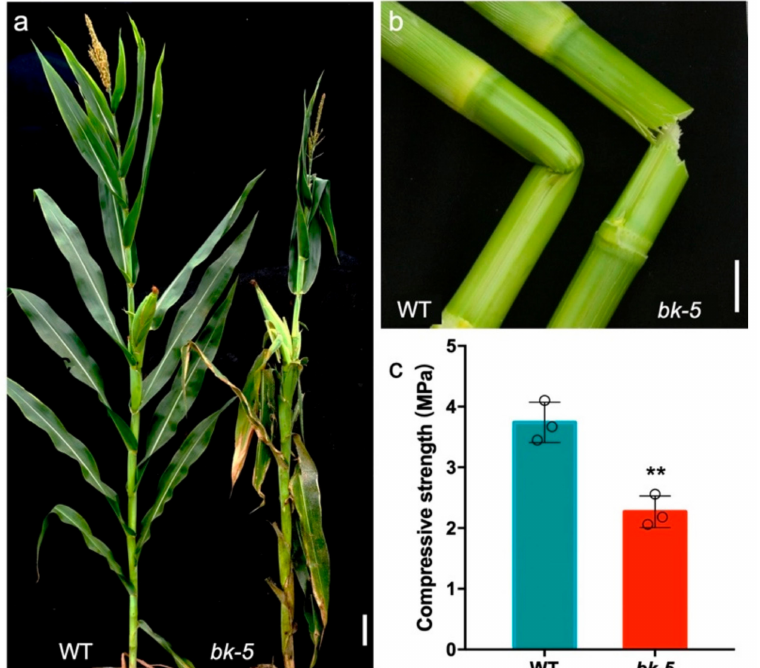
Figure 1. Characterization of bk-5 . ( a ) Comparison of the appearances of bk-5 and WT (wild-type: RP125) plants of mature stage. Scale bar: 10 cm. ( b ) Comparison of corn stalk breaking of WT (left) and bk-5 (right) stems in the jointing stage, an easily broken stalk of bk-5 was observed. They were broken off with the same force. Scale bar: 5 cm. ( c ) Compressive strength analysis of WT and bk-5 stems in mature stage, the od circles represent the measured value of each group. The data were presented as values are given as means ± SD and statistically calculated by Student’s t -test. ** ( p < 0.01) indicate significant differences between RP125 and bk-5 . Compressive strength was calculated based on three